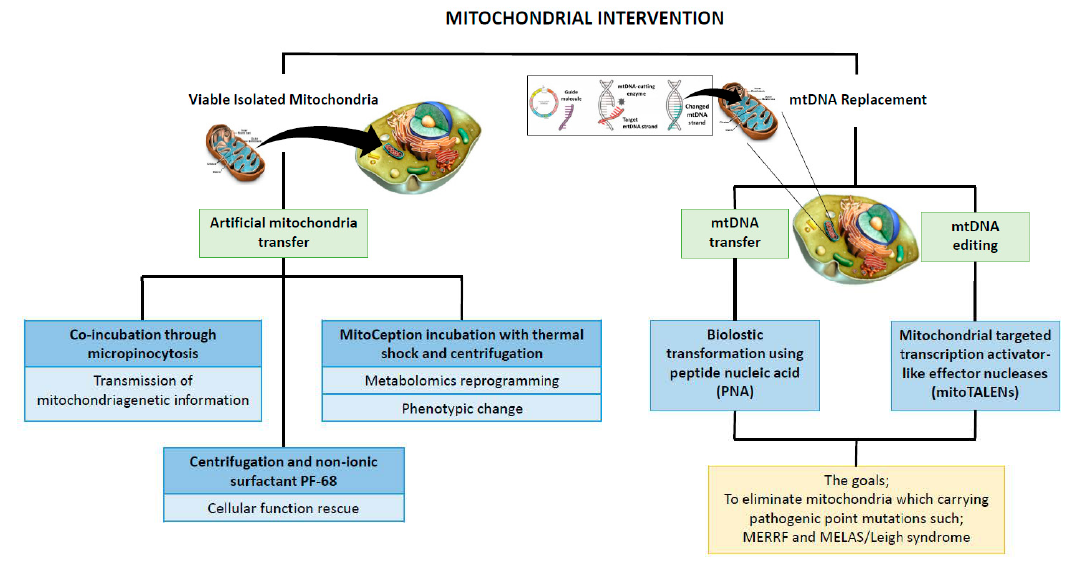
Figure 2. Advances in the past decade in manipulating mitochondria genetic content. Mitochondria transfer technologies focus on introducing exogenous mitochondria to a recipient cell. In this technique, the mtDNA is not manipulated. MtDNA replacement technology is a more specific and targeted method that can generate non-native mtDNA sequences or repair the sequences of existing mtDNA to shift the mtDNA heteroplasmy